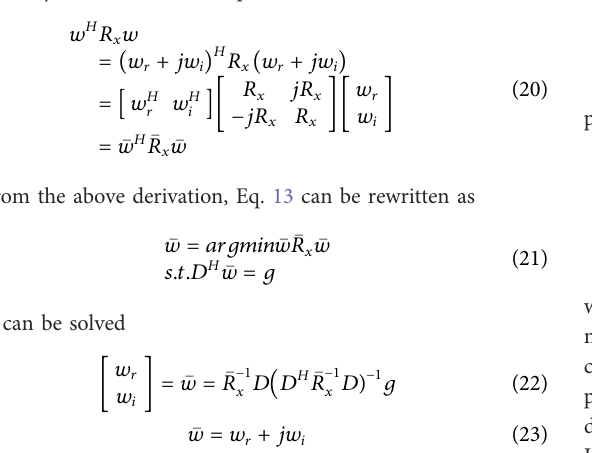
FIGURE 5 The carrier tracking